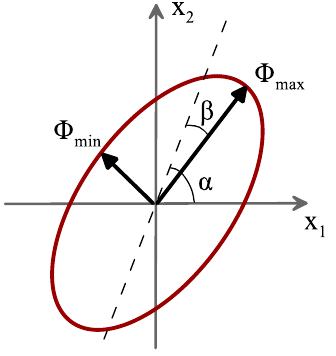
Figure 2. Construction of a phase ellipse.